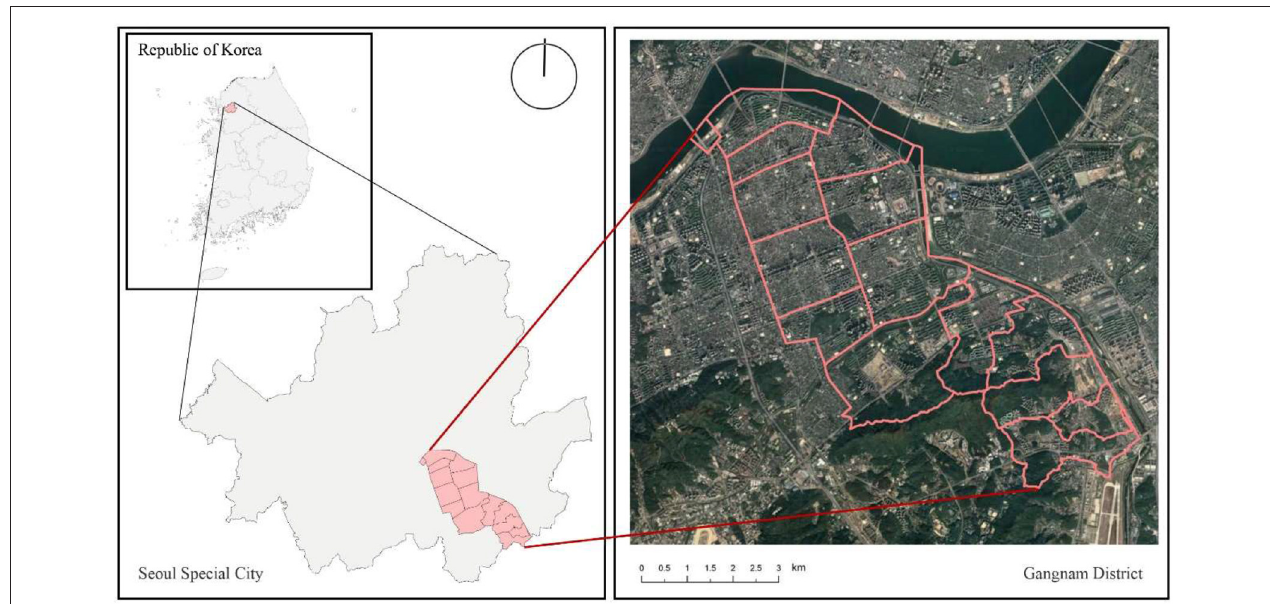
FIGURE 2 | Study area: Gangnam District, Seoul, South Korea.